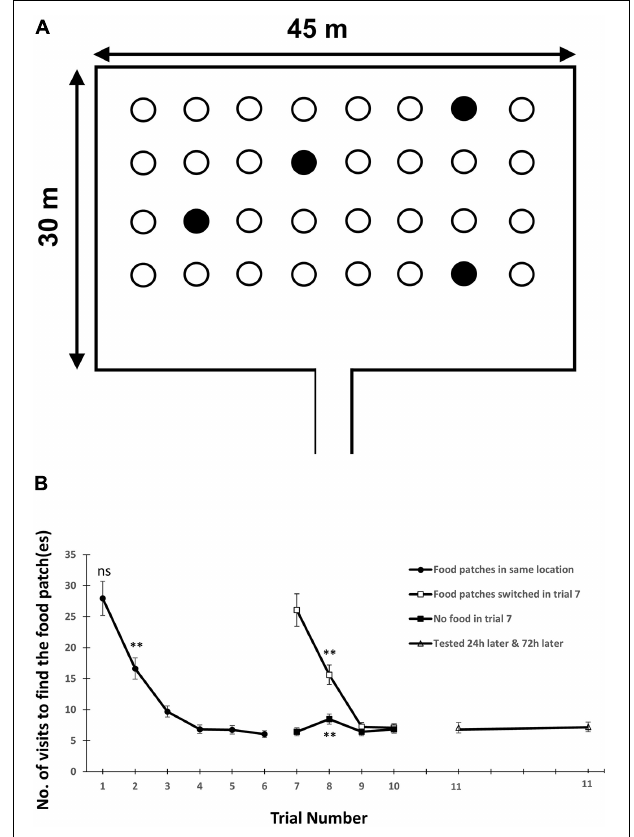
FIGURE 1 | (A) The layout of food bowls in the sheep spatial memory experiment. Open circles illustrate empty bowls while filled circles depict the four bowls containing food. (B) The mean ± SE number of visits required to locate all food bowls. In trials 1–6, the food was always in the same 4 bowls. In trial 7, half the sheep encountered food in 4 new bowls ( (cid:3) ) and these bowls also contained food in trials 8–11. The other half of the sheep encountered no food in any bowl in trial 7 ( (cid:4) ) and had food in the same bowls as in trials 1–6 in trials 8–11. In trial 11, half the sheep were tested 24 h after trial 10, and the other half were tested 72 h after trial 10. The asterisks indicate visit numbers statistically different from random search in tests conducted in trials 1, 2, and 8. Data from Edwards et al.